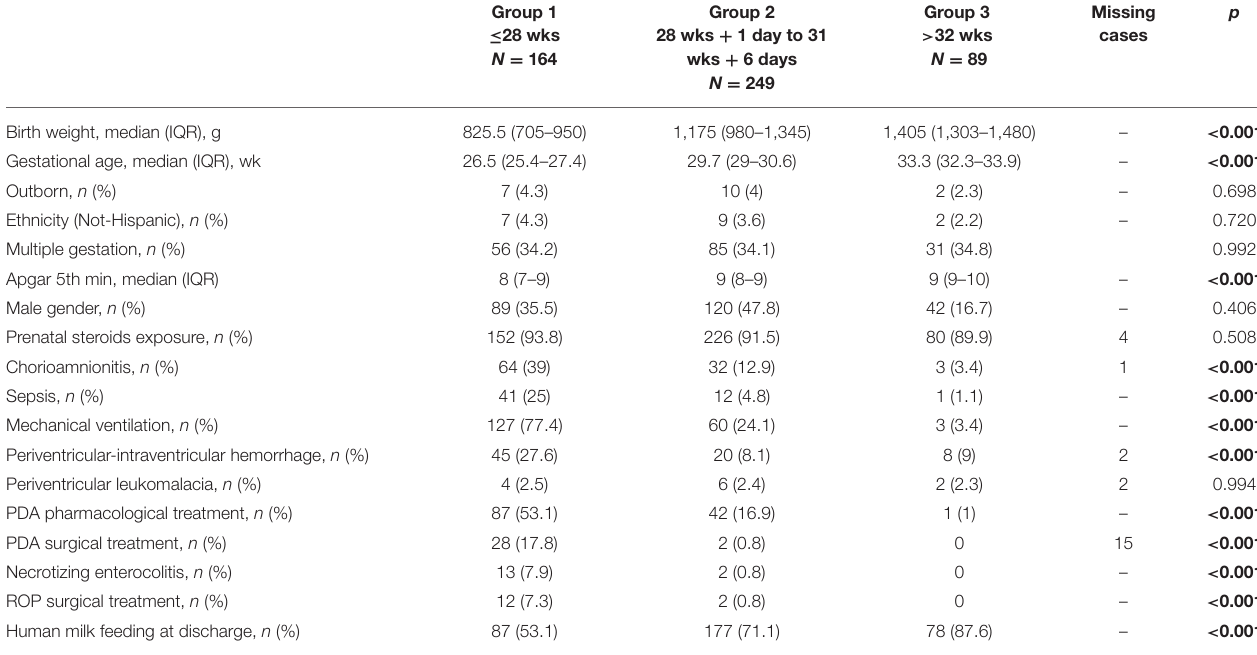
TABLE 2 | Comparison of neonatal characteristics among different gestational ages groups in patients completing 24 months follow-up * .